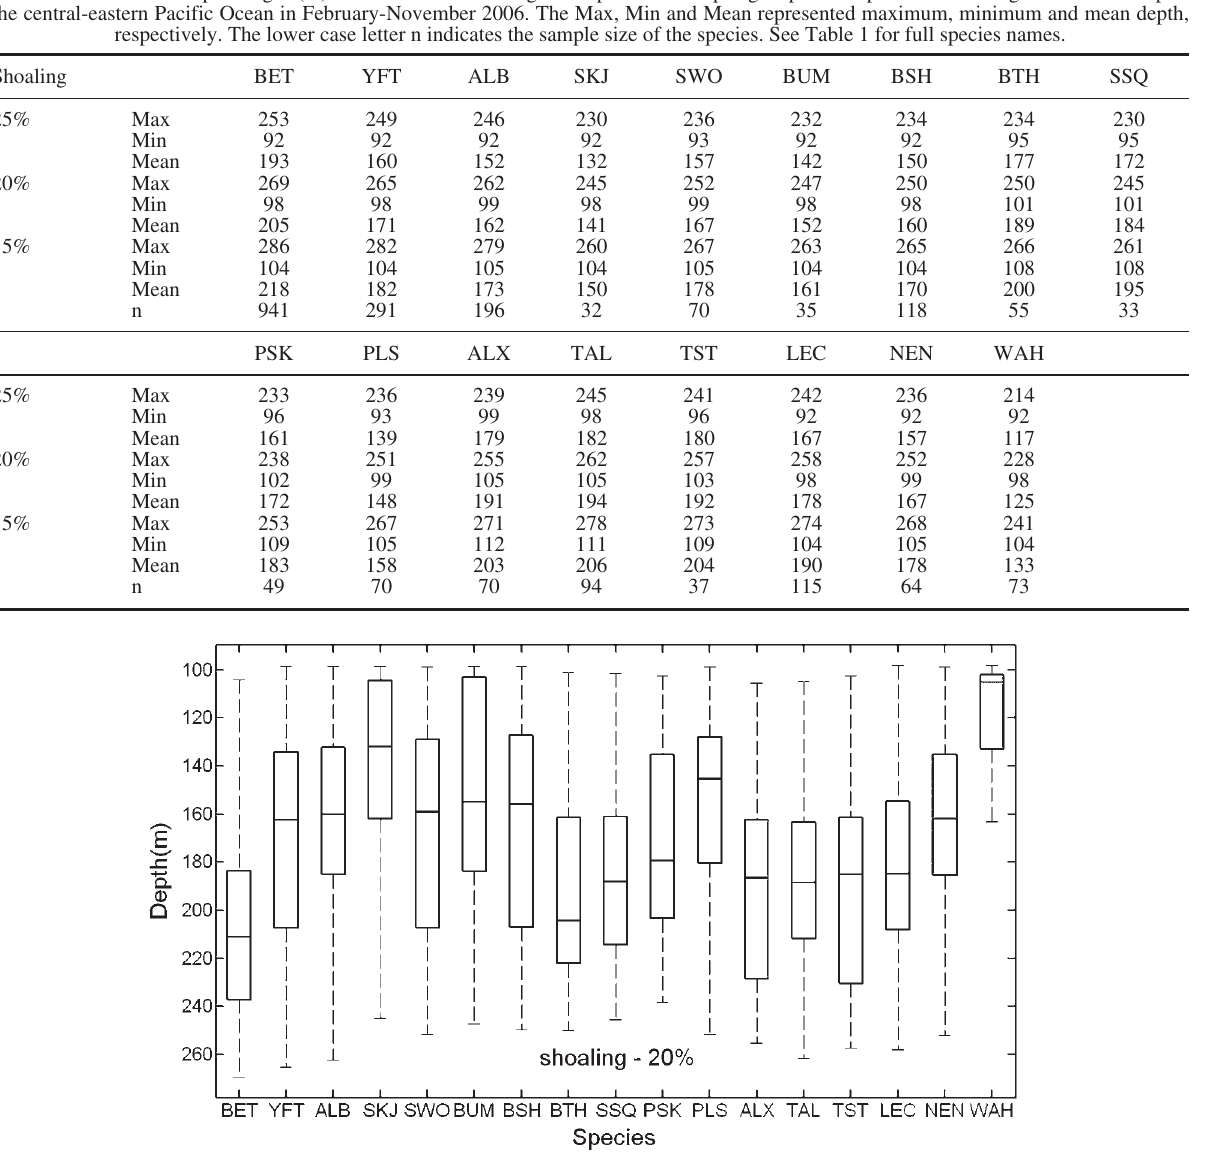
Fig . 3. – The box-plot of the estimated depth ranges under constant shoaling assumption (20%) for 17 pelagic species captured in the longline observer trip in the central-eastern Pacific Ocean in February-November 2006 (the centre line is the median depth, the edges of the box are the 25th and 75th percentiles, respectively, and the whiskers extend to the most extreme data points). See Table 1 for full species